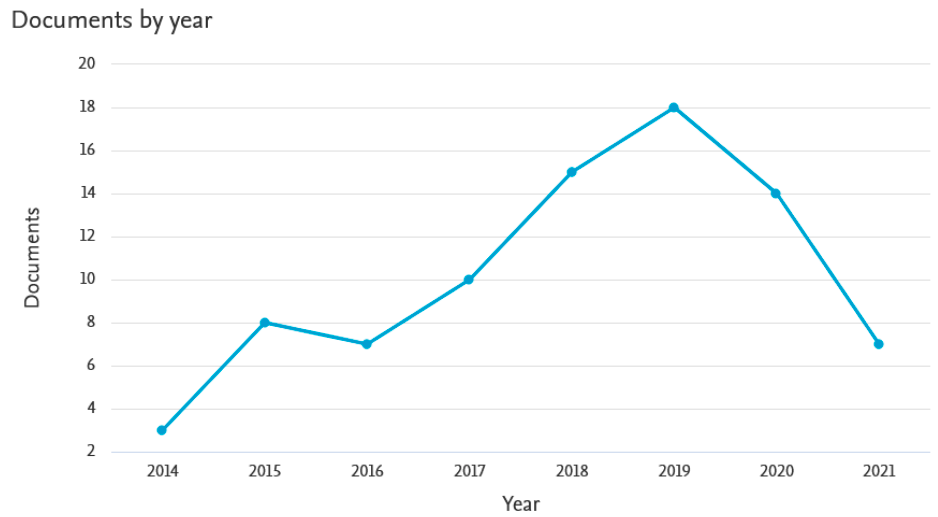
Figure 11. Documents found in Scopus for the “temporal big data” key phrase by year of publication.